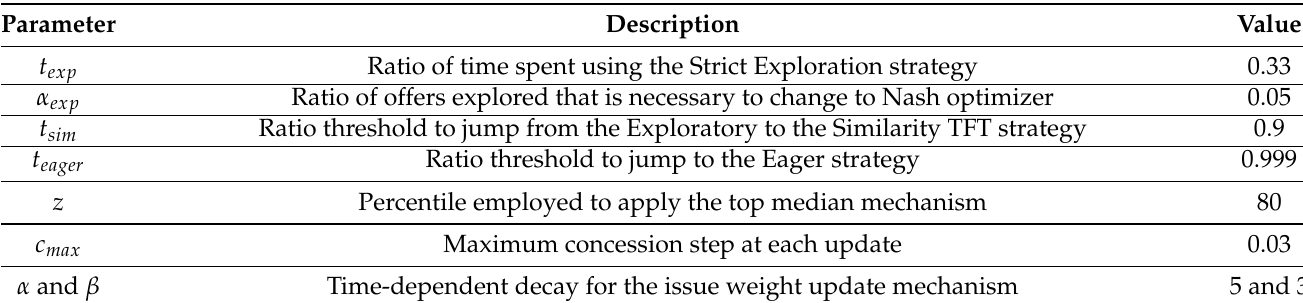
Table 2. General configuration for our social agent during the experiments.